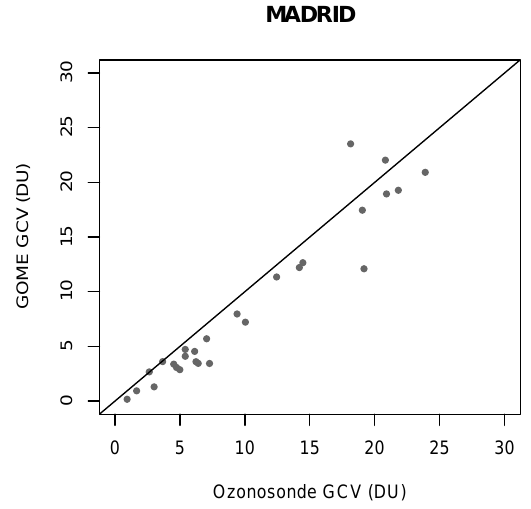
Fig. 8. GOME Ghost vertical column (GVC) versus Ozonosonde GVC at the Madrid station. Line of unit slope (solid